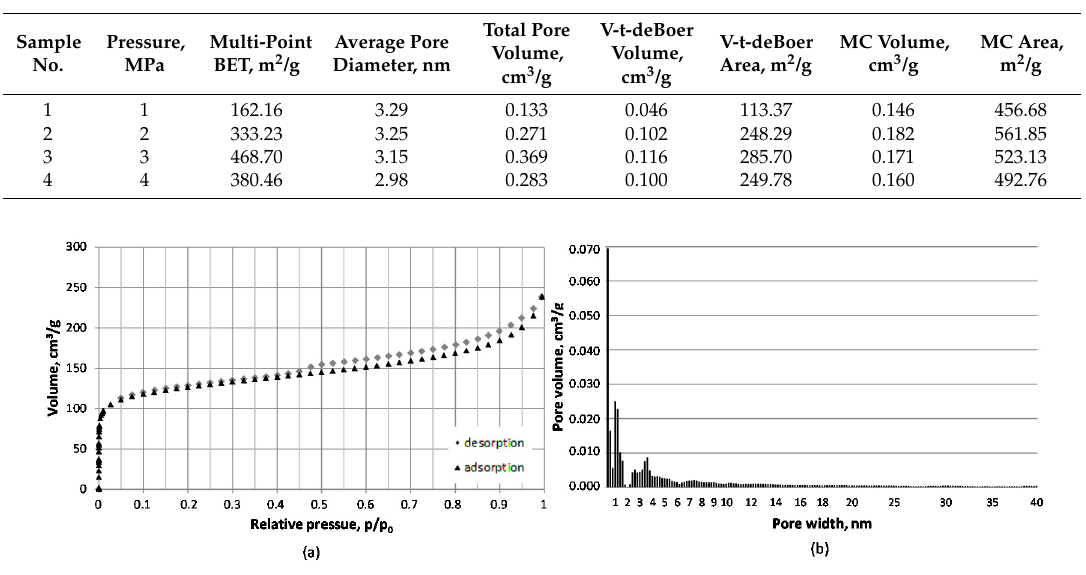
Figure 2. Nitrogen isotherm at − 196 °C ( a ) and DFT volume histogram ( b ) for carbon material produced under 3 MPa and 1000 °C.